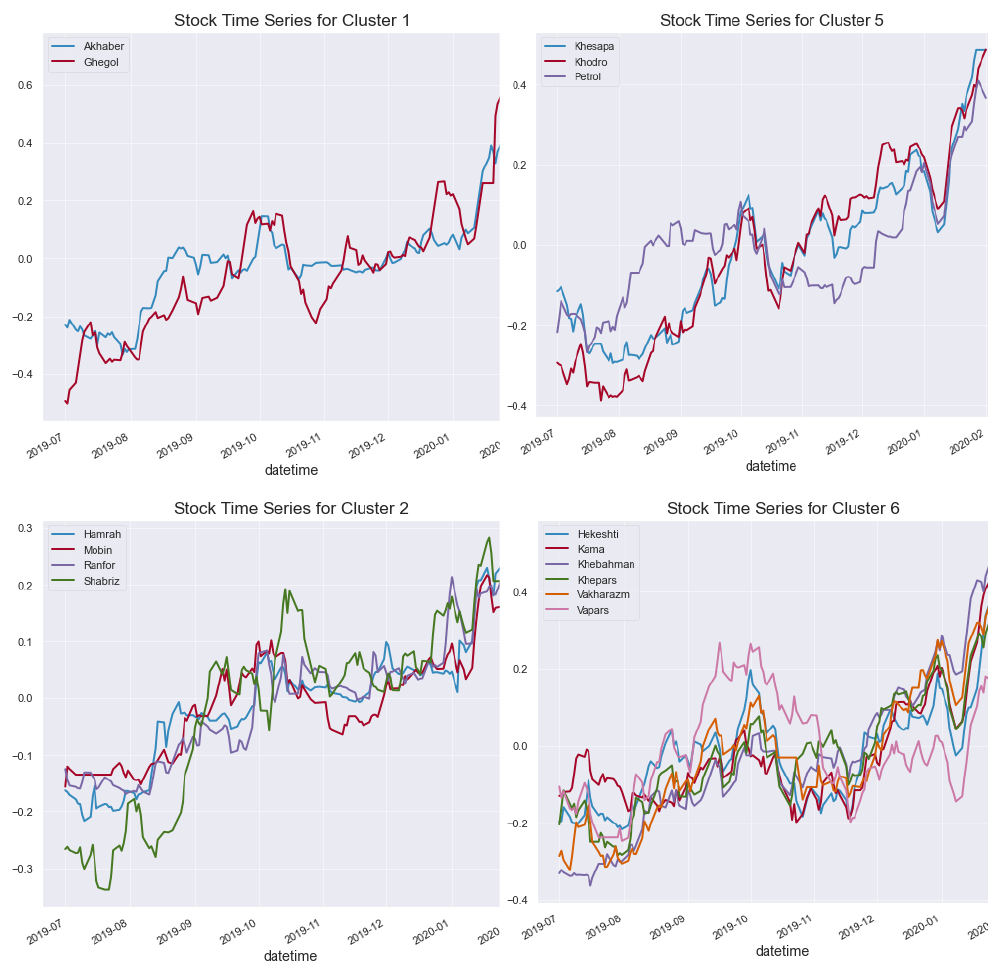
Figure 12. visualizing the return within a cluster for the date